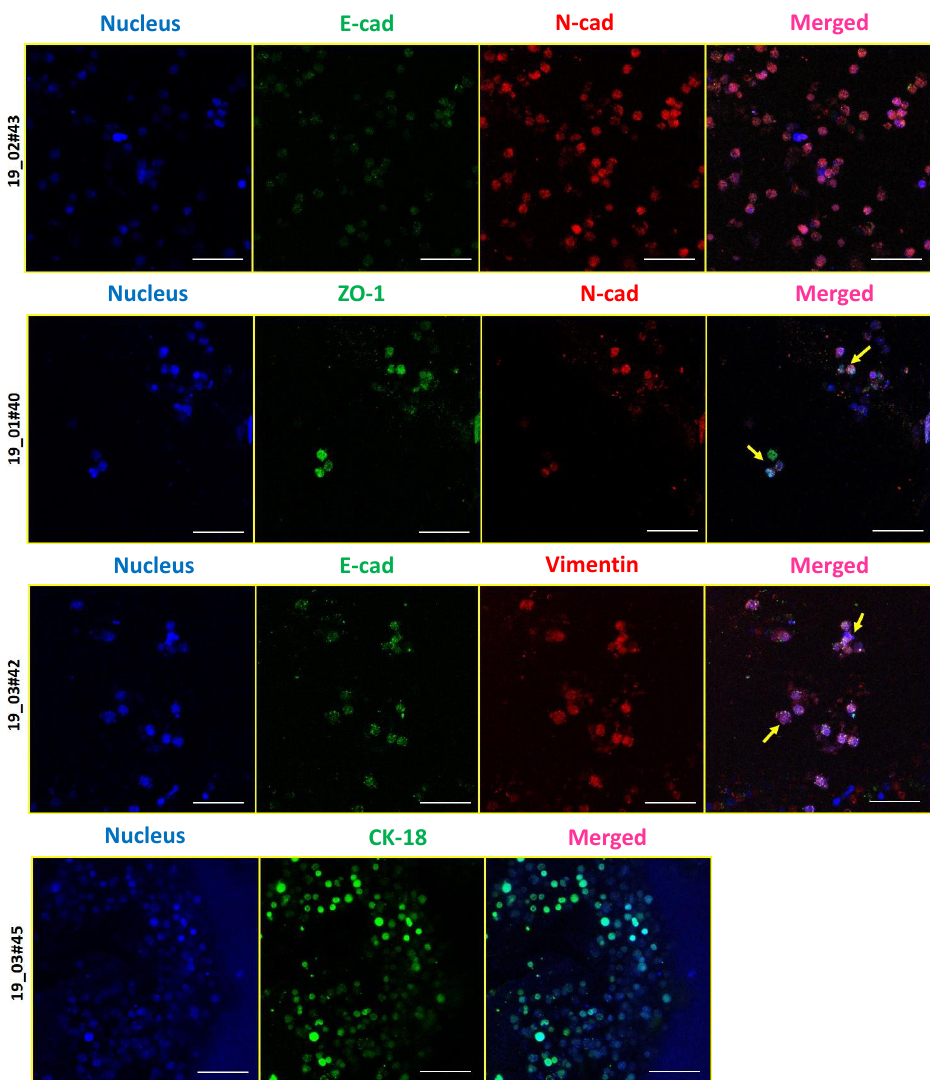
Figure 5. E-M characterization of CTCs derived from blood samples of breast cancer patients. Immunostaining revealed the presence of epithelial (E)-type CTCs expressing E-cad, ZO-1, or CK18 (green), and mesenchymal (M)-type CTCs expressing vimentin or N-cad (red). Cells were stained for nucleus (Hoechst 33342, blue). Imaging was performed using confocal microscope and maximum intensity projections are shown. Scale bar represents 40 µ m. Images are representative of 4 independent patient